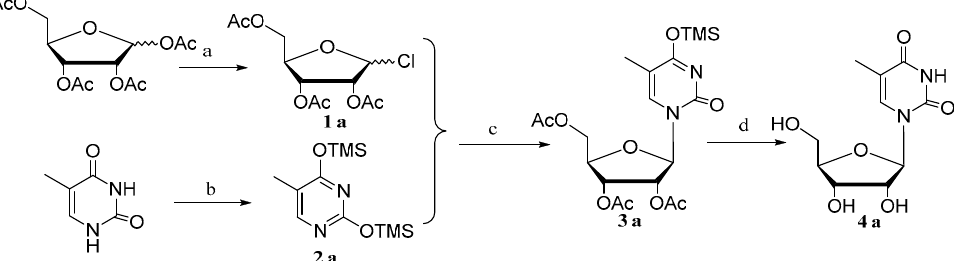
Figure 2. Synthesis of ribosylthymine.